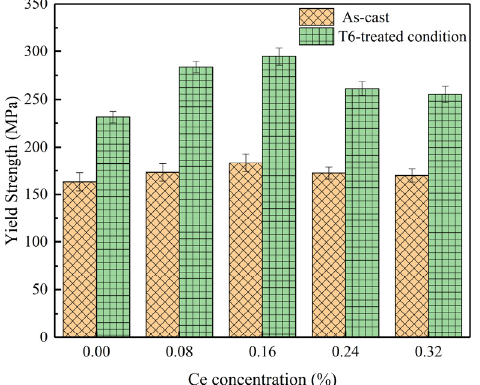
ff erent Ce content. Metals 2020 , 10 , x FOR PEER REVIEW